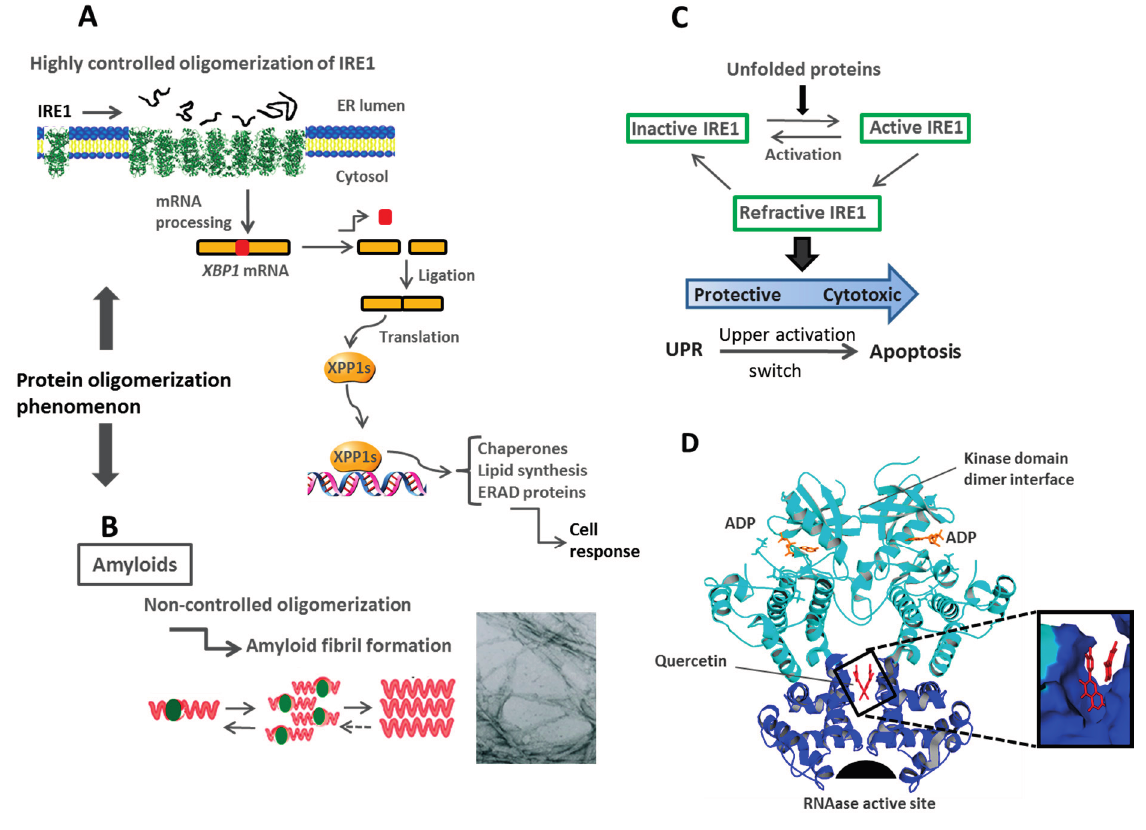
Figure 3. Activation of the inositol requiring enzyme 1 (IRE1) branch of the unfolded protein response (UPR) pathway is tightly controlled. ( A ) Schematic representation of IRE1 oligomerization and cellular response induced by unfolded proteins. The structure employed was obtained from the protein data bank (PDB) access code: 3fbv; ( B ) Uncontrolled protein aggregation in the formation of amyloid fibrils; ( C ) Effect of the overactivation of IRE1 branch on cellular homeostasis. Adapted from reference [141]; ( D ) Structural representation of IRE1 with a focus on the surface of interaction between monomers. Inset: sterol binding site, with two bound molecules of quercetin. Structure was obtained from PDB access code: